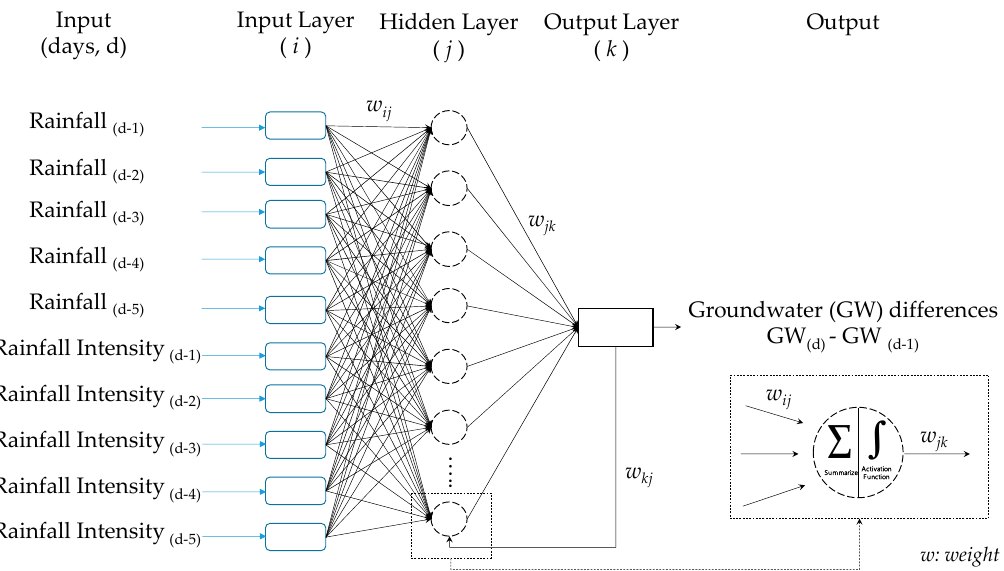
Figure 5. Illustration of the multilayer perception (MLP) model, after [39].